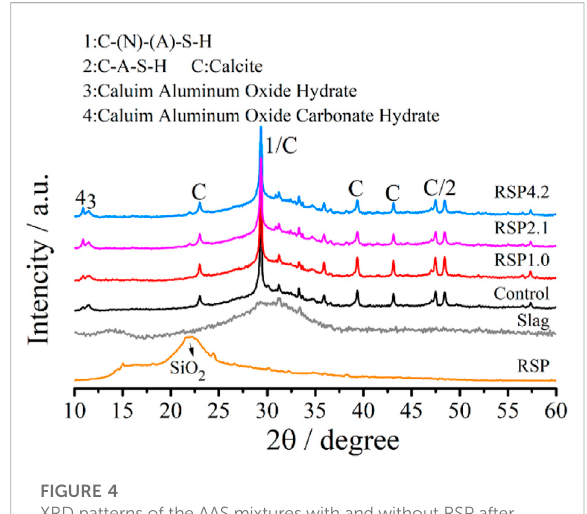
FIGURE 4 XRD patterns of the AAS mixtures with and without RSP after 28 days of